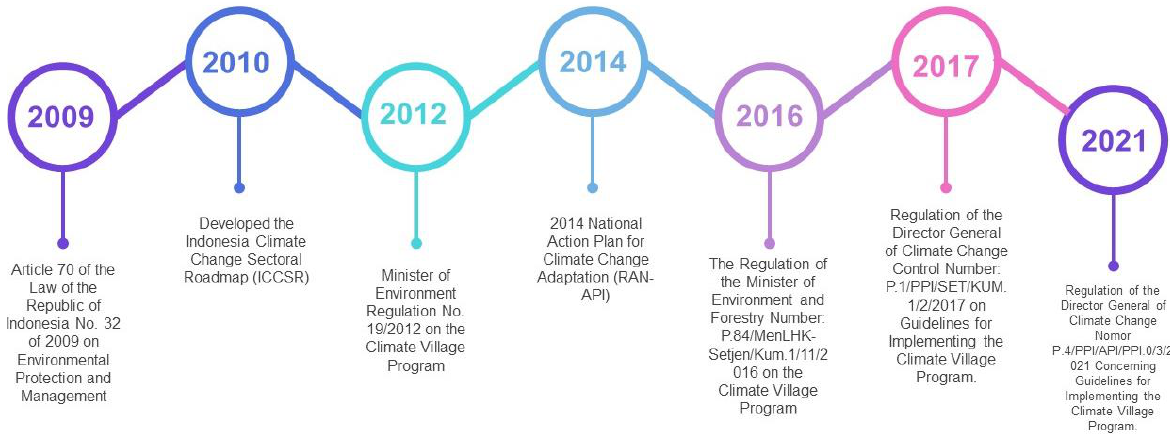
Figure 4. History of Climate Village (Kampung Iklim) Policy in Indonesia (source: authors, adapted from Ministry of Environment and Forestry (MoEF)).